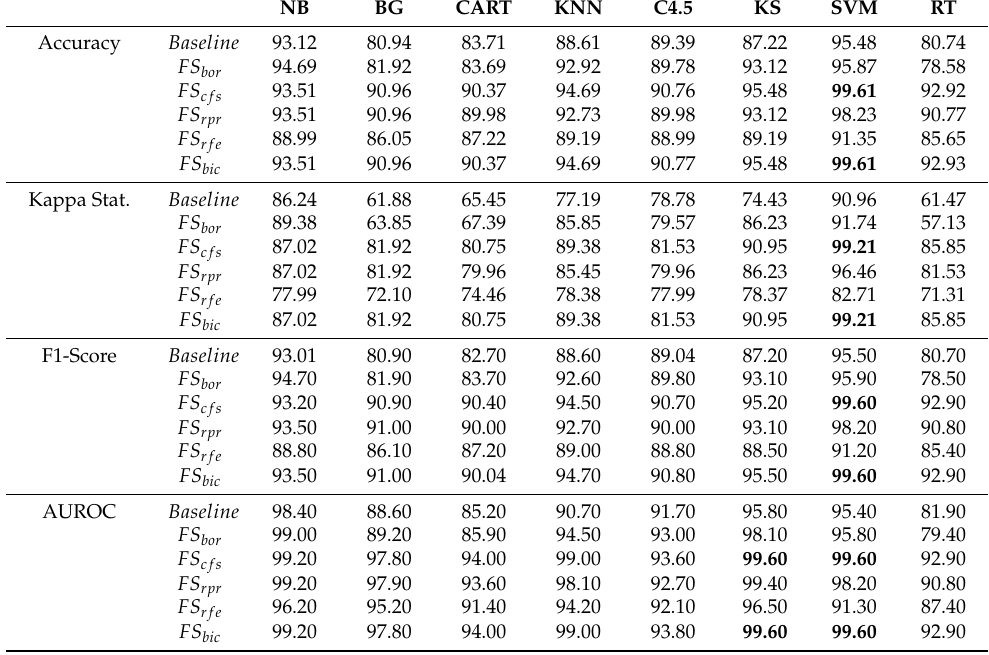
Table 6. Performance analysis of classifiers for baseline and its generated feature subsets of